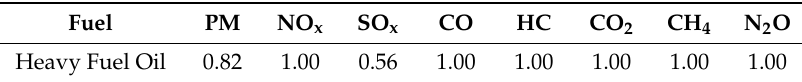
Table 5. Fuel correction factors [28].